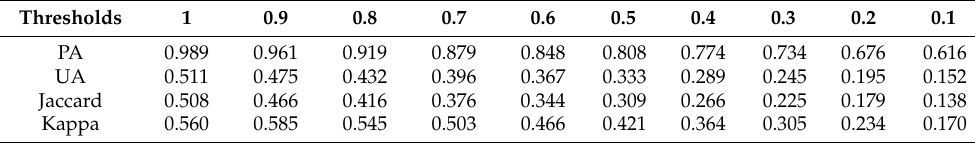
Table 2. Kudzu classification performance based on linear unmixing of the entire area of Knox